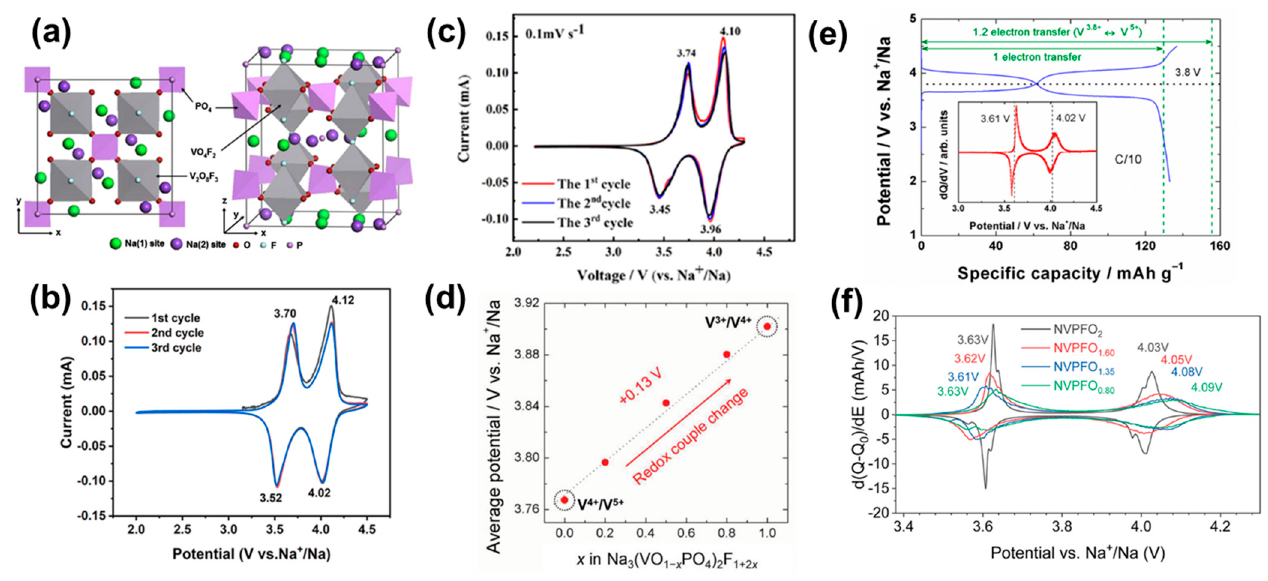
Figure 5. ( a ) The crystal structure of Na 3 V 2 (PO 4 ) 2 F 3 [86]. ( b ) CV curves of Na 3 V 2 (PO 4 ) 2 F 3 for the first three cycles at 0.1 mV s − 1 [93]. ( c ) CV curves of Na 3 V 2 (PO 4 ) 2 O 2 F at a scan rate of 0.5 mV s − 1 [94]. ( d ) Tends in average voltages of the Na y (VO 1 − x PO 4 ) 2 F 1+2x compound as x increases. [95]. ( e ) Charge/discharge profile at a C/10 rate for the Na 3 V 2 (PO 4 ) 2 O 1.6 F 1.4 cathode and the corresponding dQ/dV curve inset [40]. ( f ) The dQ/dV curves for Na 3 V 3+2 − y V 4+y (PO 4 ) 2 F 3 − y O y electrode materials corresponding to the 5th cycle performed at C/20 [96].